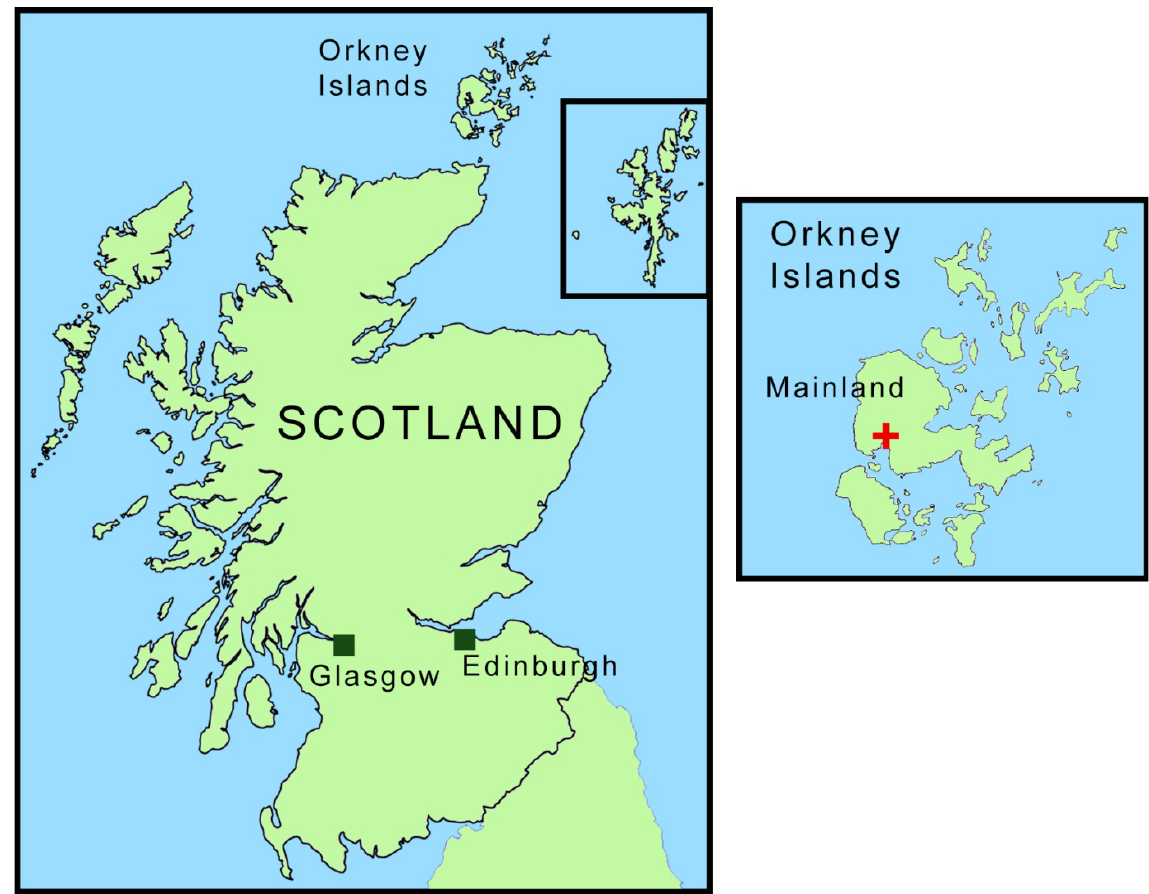
Figure 2. Location map. The cross on Mainland Orkney marks the approximate find location of the Brodgar point, on the Ness of Brodgar in Stenness